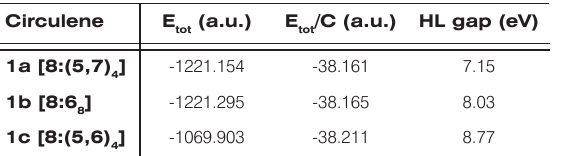
Table 2. Total energy, total energy per carbon atom and HOMO- LUMO HL gap of circulenes 1a to 1c (HF/6-311G(d,p)). Circulene